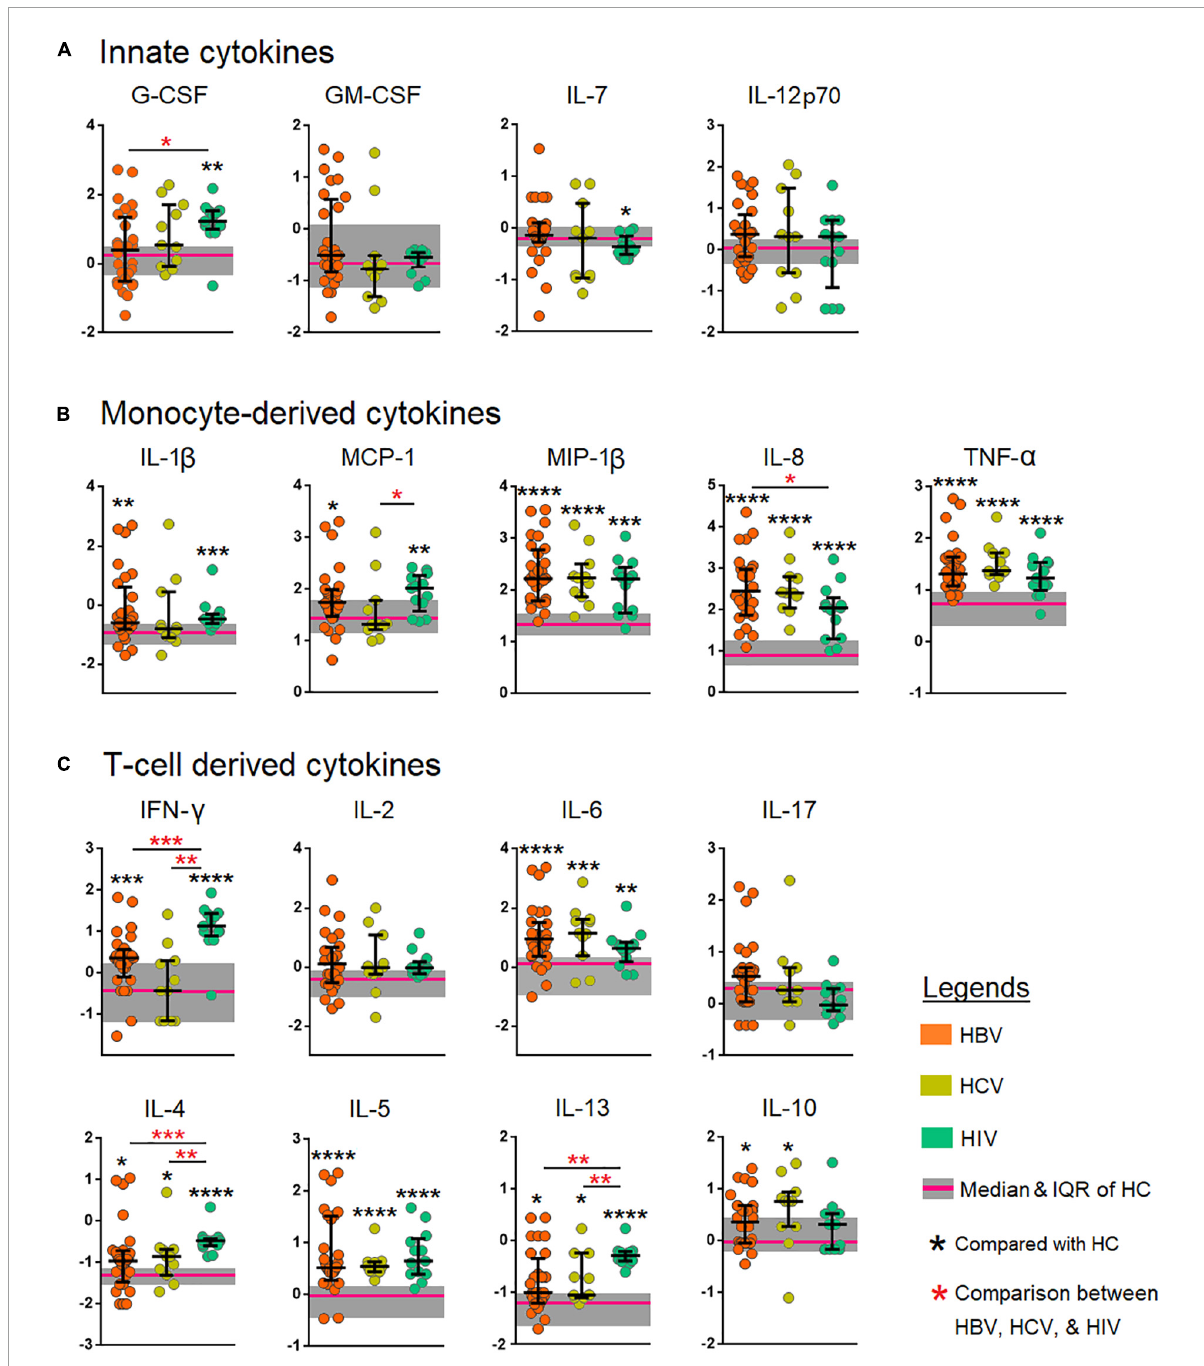
FIGURE2 Comparison of the levels of cytokines among patients chronically infected with hepatitis B virus (HBV), hepatitis C virus (HCV), and human immunodeficiency virus (HIV). (A) Innate cytokines (B) Monocyte-derived cytokines, and (C) T cell-derived cytokines. The cytokines were compared across the three patient groups by the Kruskal–Wallis test. Post-hoc Mann–Whitney U tests were subsequently performed only for those biomarkers with a Kruskal–Wallis test p -value of < 0.05. p -values < 0.05 are considered significant; * p < 0.05, ** p < 0.01, *** p < 0.001, **** p < 0.0001. G-CSF, granulocyte-colony stimulating factor; GM-CSF, granulocyte-macrophage colony-stimulating factor; IFN- γ , interferon gamma; MCP-1, monocyte chemoattractant protein-1; MIP-1 β , macrophage inflammatory protein-1 beta; TNF- α , tumor necrosis factor alpha; IL,